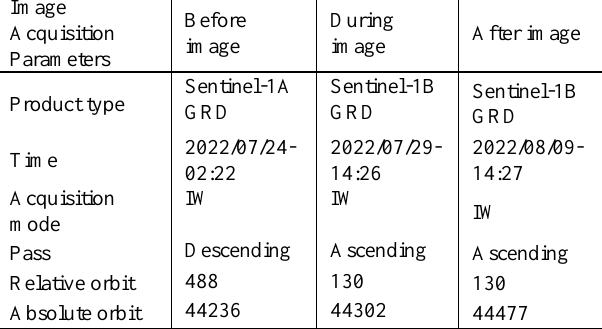
Table 1. Sentinel-1 datasets used in the present